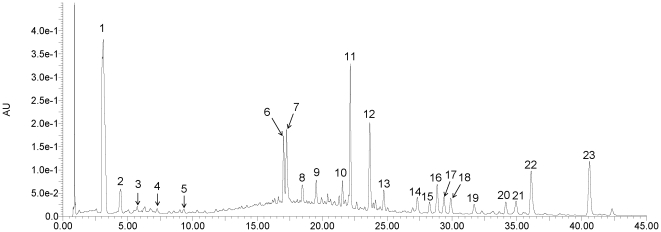
UPLC/UV chromatogram at 280 nm of the extract of Rheum palmatum L.Seventeen compounds were identified by electrospray ionization tandem mass spectrometry: galloyl glucose (1), glucopyranosyl-galloyl-glucose (3), catechin glucopyranoside (4), isomer of catechin glucopyranoside (5), aloe emodin O-glucoside (9), rhein O-glucoside (10), cinnamoyl-O-galloyl-glucose (11), laccaic acid D O-glucoside (13), dehydroxylaccaic acid D O-glucoside (14), chrysophanol O-glucoside (15), isomer of chrysophanol O-glucoside (16), emodin O-glucoside (17), laccaic acid D (19), physcion O-glucoside (20), emodin (21), acetyl- chrysophanol (22) and physcion (23). The other six chromatographic peaks (2, 6-8, 12 and 18) are unknown compounds.